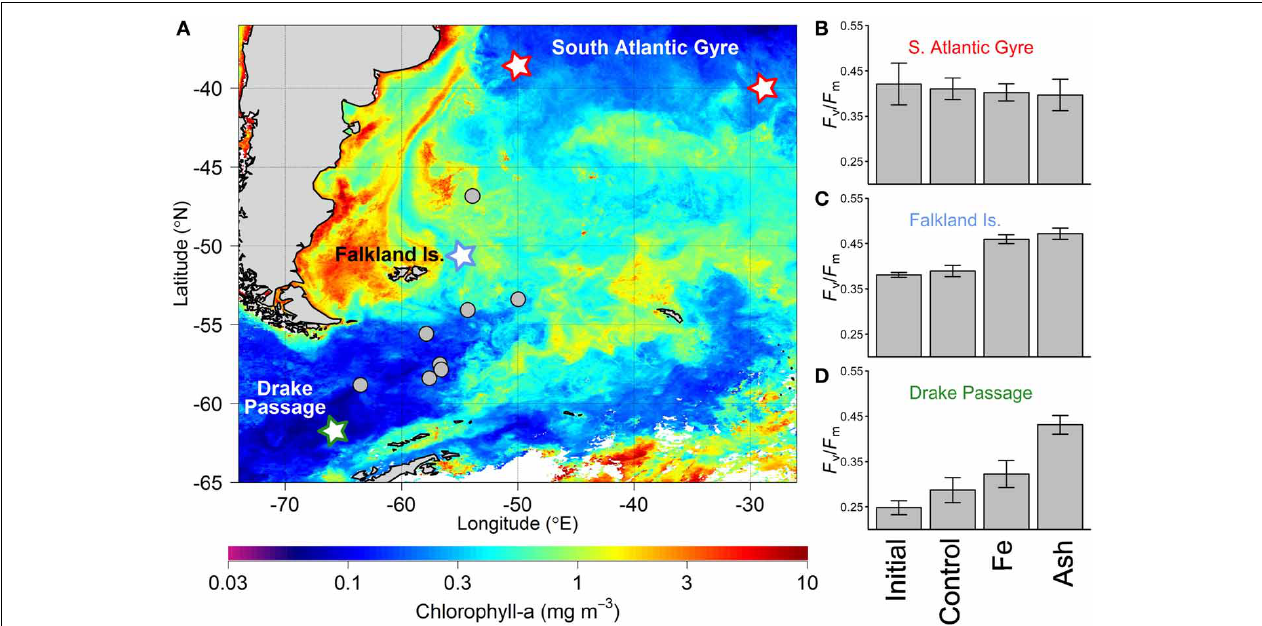
FIGURE 2 | Bottle-scale 24-h duration ash addition experiments performed by Browning et al. (2014a). (A) Satellite-derived chlorophyll-a concentrations averaged over the time period of experiments (January-March 2012). Experiment locations are plotted, with those highlighted in (B–D) identified with a related color star. (B–D) Phytoplankton community-level F v / F m response to separate Fe and ash addition experiments in three distinct biogeochemical regimes. Bars and error bars indicate the mean and standard deviation of responses respectively. “Initial” indicates initial phytoplankton F v / F m (results for both subtropical gyre experiments highlighted in (A) were averaged, thus n = 6,